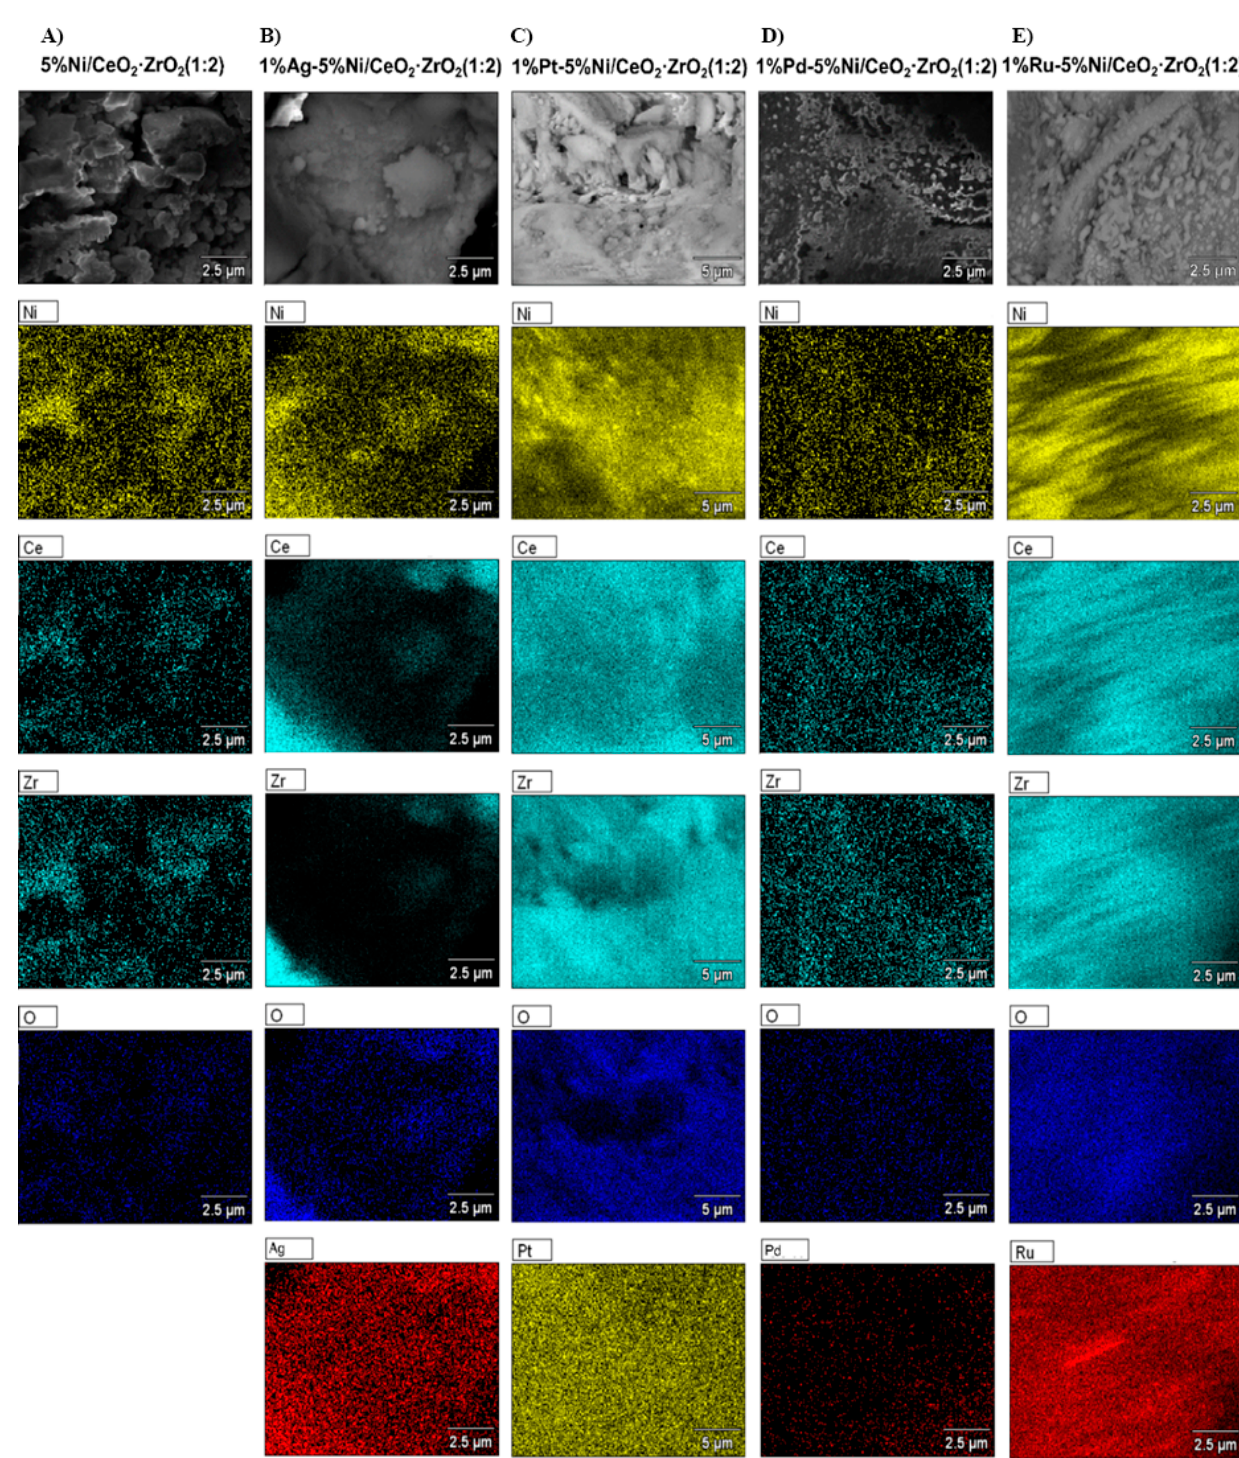
Figure 7. SEM-EDS images of ( A ) monometallic 5%Ni/CeO 2 · ZrO 2 (1:2) and bimetallic catalysts ( B ) 1%Ag-5%Ni/CeO 2 · ZrO 2 Figure 7. SEM ‐ EDS images of ( A ) monometallic 5%Ni/CeO 2 ∙ ZrO 2 (1:2) and bimetallic catalysts ( B ) 1%Ag ‐ 5%Ni/CeO 2 ∙ ZrO 2 ( C ) 1%Pt-5%Ni/CeO 2 · ZrO 2 ( D ) 1%Pd-5%Ni/CeO 2 · ZrO 2 ( E ) 1%Ru-5%Ni/CeO 2 · ZrO 2 calcined in an air atmosphere at ( C ) 1%Pt ‐ 5%Ni/CeO 2 ∙ ZrO 2 ( D ) 1%Pd ‐ 5%Ni/CeO 2 ∙ ZrO 2 ( E ) 1%Ru ‐ 5%Ni/CeO 2 ∙ ZrO 2 calcined in an air atmosphere at 400 °C 400 ◦ C for 4 for 4 h .